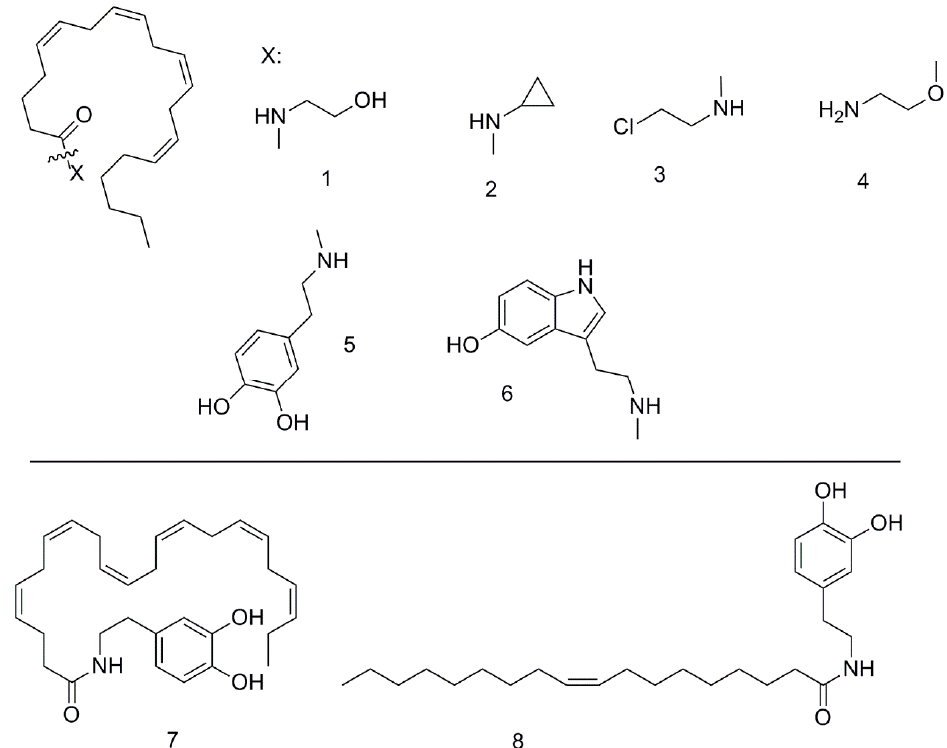
Figure 1. The structures of the compounds used in this work: 1, N -arachidonyl ethanolamine (AAEA), 2, arachidonoyl cyclopropylamine, 3, arachidonoyl 2-chlorethylamine, 4, O-arachidonoyl ethanolamine (VRD), 5, arachidonoyl dopamine, 6, arachidonoyl serotonin, 7, docosahexaenoyl dopamine, 8, oleoyl dopamine.